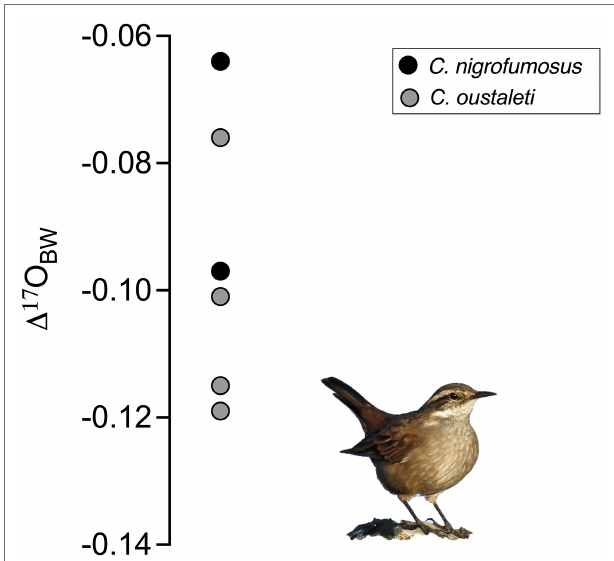
FIGURE 3 | Δ' 17 O values for six Cinclodes individuals sampled at Los Molles, a coastal locality in central Chile characterized by moderate temperatures and low